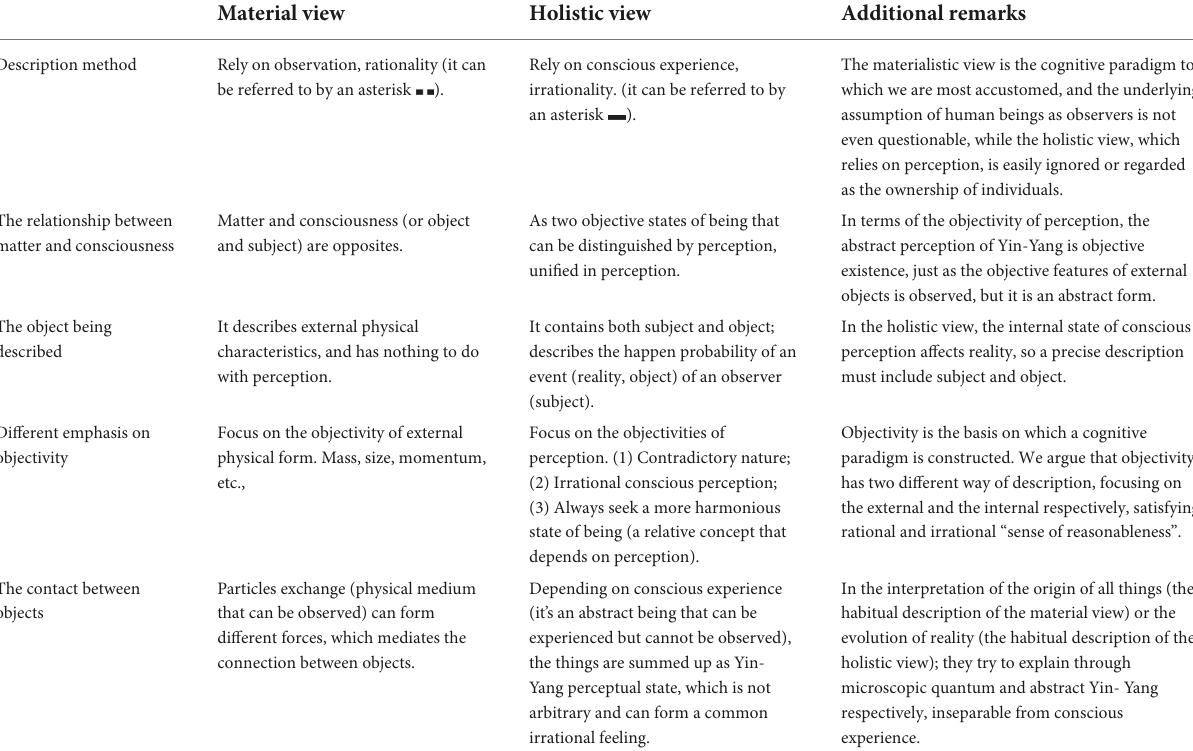
TABLE 3 A contrast between the material view and the holistic view cognitive